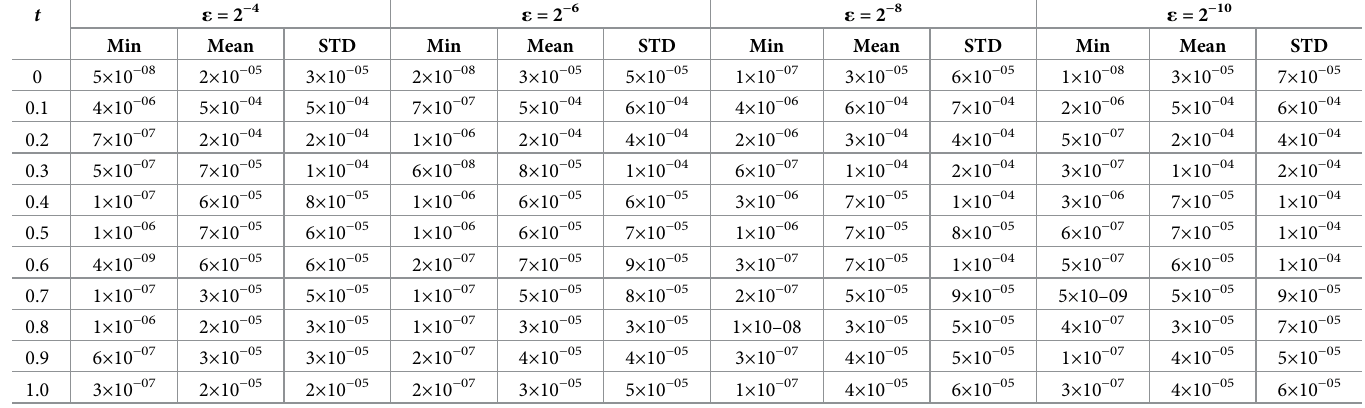
Table 3. Statistics results of AE for each case of problem